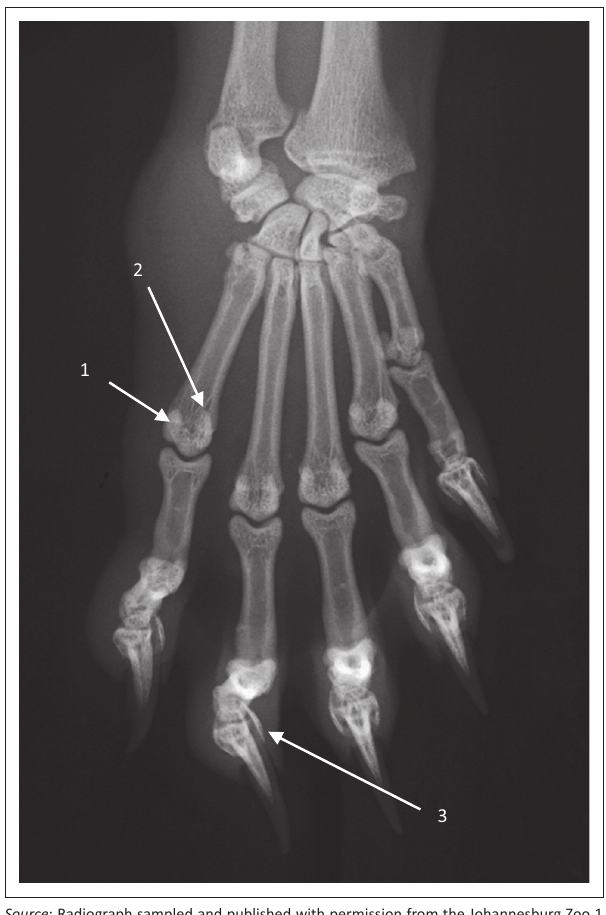
FIGURE 9: Dorsopalmar radiograph of the right manus of a 1.4-year-old female red